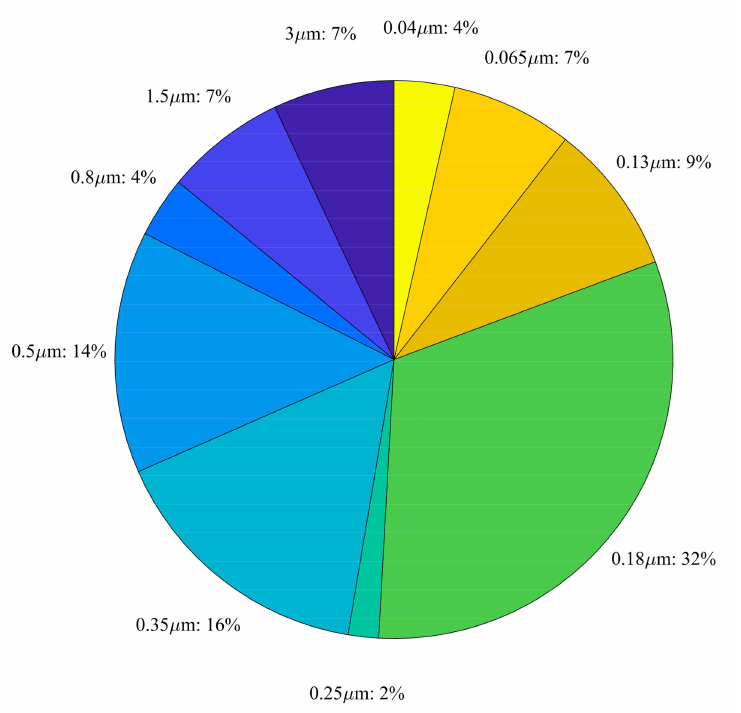
Figure 5. Break-down of CMOS Technology nodes used in the publications of Figure